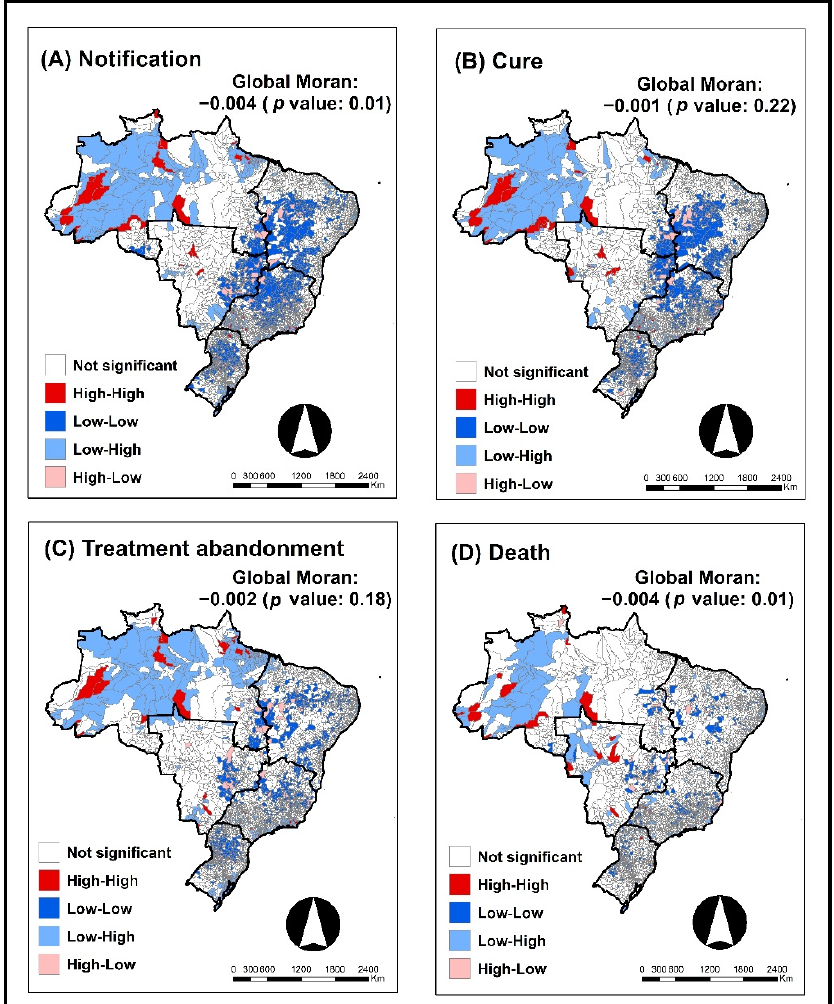
Figure 3. Analysis of bivariate spatial autocorrelation between the notification rate of COVID-19 and notification of TB and its outcome (cure, treatment abandonment, and death) according to Brazilian municipalities (2020–2021). ( A )-Application of the Global and Local Bivariate Moran technique between reported cases of COVID-19 and reported cases of tuberculosis. ( B )-Application of the Global and Local Bivariate Moran technique between reported cases of COVID-19 and cured tuberculosis cases. ( C )-Application of the Global and Local Bivariate Moran technique between reported cases of COVID-19 and tuberculosis cases that abandoned treatment. ( D )-Application of the Global and Local Bivariate Moran technique between reported cases of COVID-19 and tuberculosis cases that had death as an outcome.